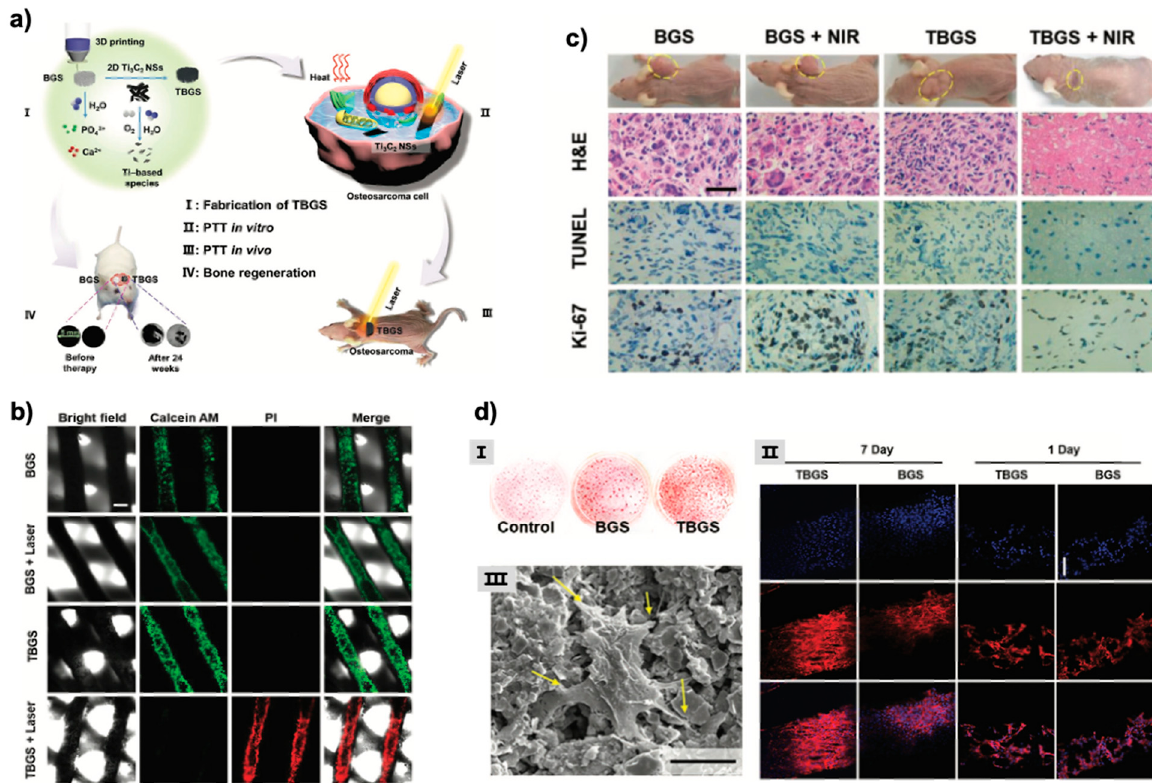
Figure 9. ( a ) Schematic illustration of the fabrication of TBGS, ablation of bone cancer, and regeneration of bone tissue: (I) Fabrication procedure of TBGS, including 3D printing of pure BGS, integration of Ti3C2 MXene, and degradation of Ti3C2 MXene on BGS. (II, III) TBGS used for osteosarcoma cell elimination by photothermal ablation both in vitro (II) and in vivo (III). (IV) Bone-tissue reconstruction and the therapeutic results after the implantation of BGS and TBGS. ( b ) In vitro photothermal-performance evaluation of TBGSs: CLSM images of live (green) and dead Saos-2 cells (red) on BGSs or TBGSs with different treatments. Scale bar is 200 mm. ( c ) In vivo photothermal-performance evaluation of TBGSs: Photographs of Saos-2 tumor-bearing mice on 14th day after different treatments, and the tumor tissues stained by H&E, TUNEL (apop- tosis), and Ki-67 (proliferation) in 1 day after different treatments (scale bars: 10 mm). ( d ) In vitro evaluation on the pro- liferation and osteogenic differentiation as assisted by BGS/TBGSs for bone regeneration: (I) Alizarin red S staining of control, BGSs, and TBGSs at day 21. (II) CLSM images of hBMSCs stained with DAPI (cell nuclei, blue) and rhodamine phalloidin (cytoskeleton, red) on BGSs/TBGSs at days 1 and 7 (scale bar: 100 mm). (II) SEM image of hBMSCs after seeding on 1.0 TBGS for 1 day (scale bar: 5 mm). Adapted from ref. [142].